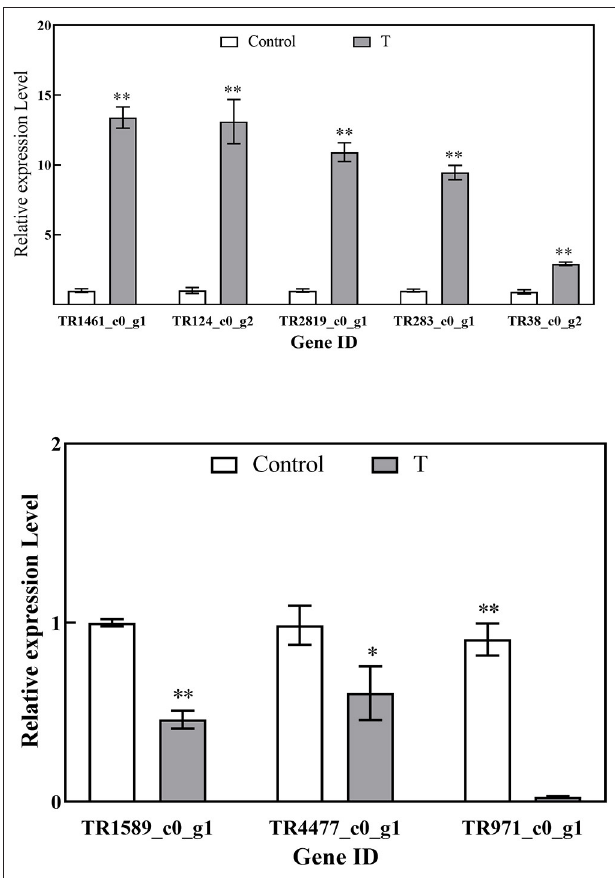
FIGURE 9 | Relative expression levels of DEGs by RT-qPCR. Values are the mean ± standard deviation (SD) of three replicates. The “*”, “**” above the bars on columns indicate a significant difference ( P < 0.05, P < 0.01) compared with